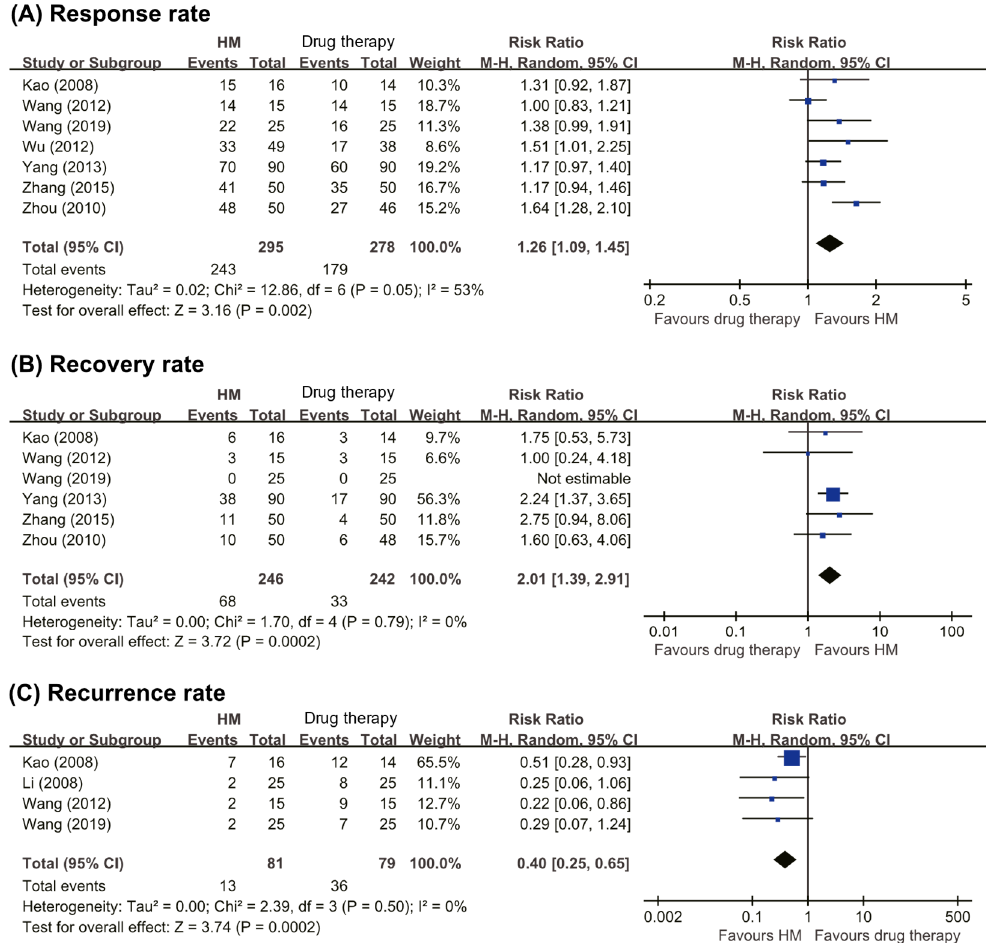
Figure 3. Forest plots of ( A ) total response rate, ( B ) recovery rate, and ( C ) recurrence rate. HM: herbal medicine.